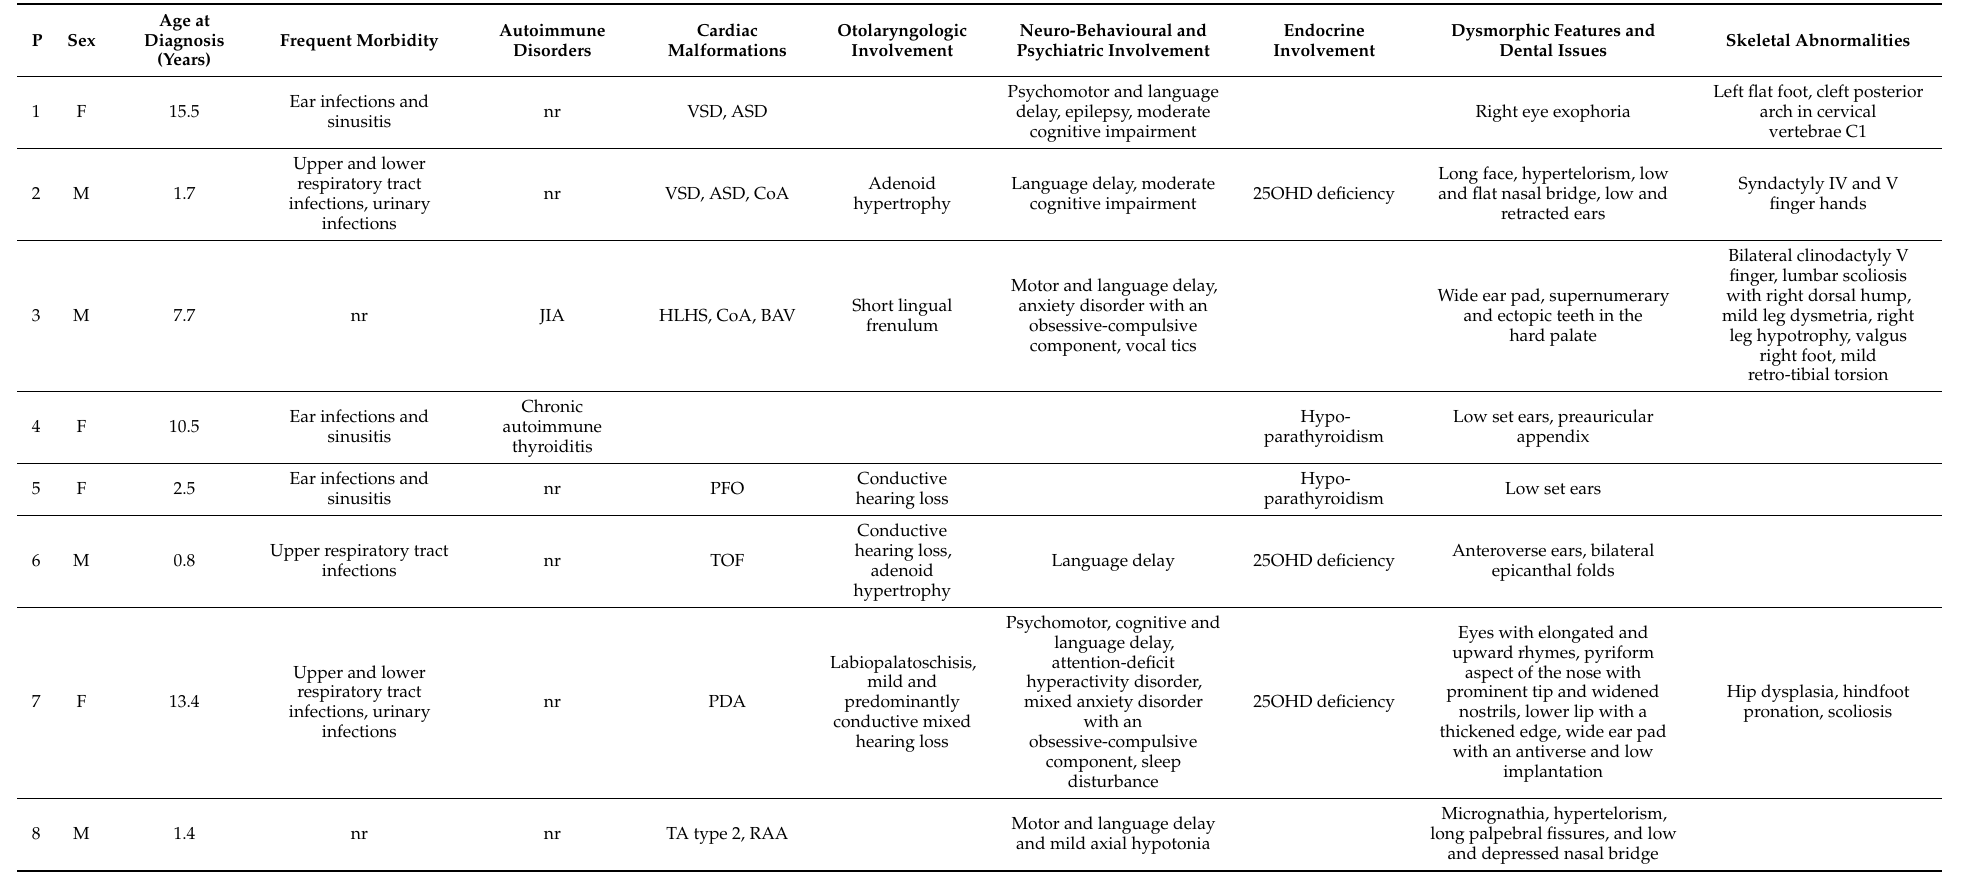
Table 1. Clinical features of the